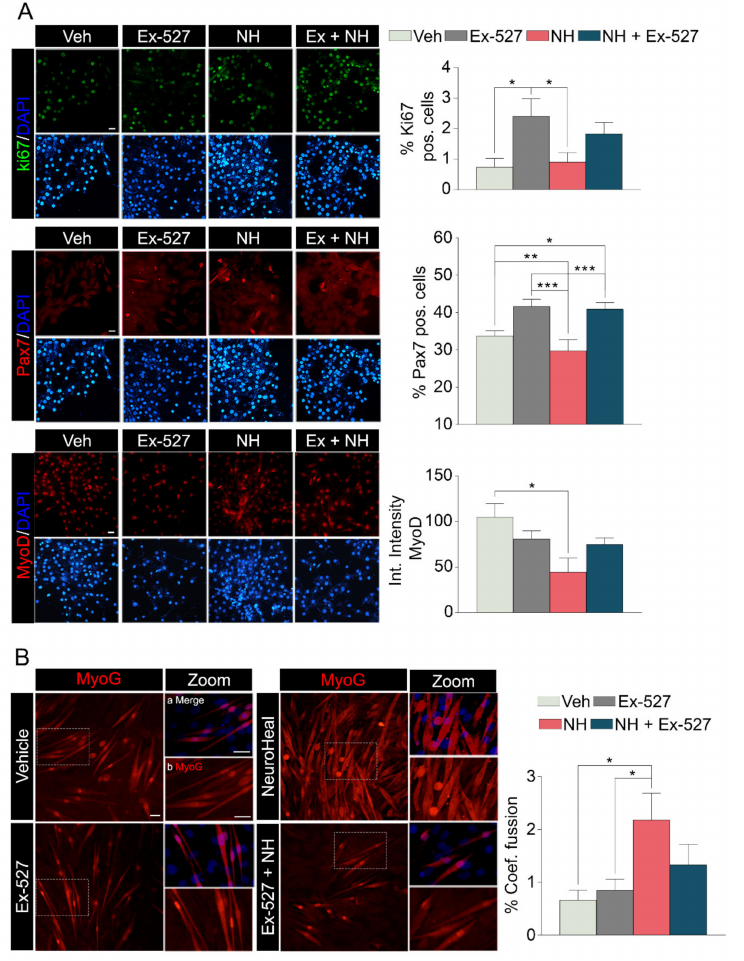
Figure 4. NeuroHeal modulates differentiation process and increases myoblast fusion in vitro. ( A ) Left, representative microphotographs of differentiated C2C12 myoblast cell line immunostained for Ki67, Pax7, and MyoD and stained with DAPI from the different experimental groups at 3 days of differentiation: atrophy-induced treated with vehicle (Veh), atrophy-induced treated with Ex-527 (Ex-527), atrophy-induced treated with NeuroHeal (NH), and atrophy-induced treated with NH plus Ex-527. Scale bar 25 µ m and identical for all corresponding microphotographs as represented in the first image panel, the vehicle condition. Right, bar graph of the average number of positive nuclei for Ki67 and Pax7, and the relative intensity per cell of MyoD ( n = 3; one-way ANOVA, * p < 0.05, ** p < 0.01, *** p < 0.001). ( B ) Left, representative immunofluorescence microphotographs of differentiated C2C12 myoblast cell line immunostained for MyHC and stained with DAPI (blue) from the different experimental groups at 5 days of differentiation. Panels a and b are zoom images for each condition from the images of the left. The scale bar is 200 µ m for all corresponding microphotographs as represented in the first image panel, the vehicle condition, and zoomed images. Right, bar graph of the percentage of the number of positive myotubes with three or more nuclei ( n = 3, one-way ANOVA, * p <